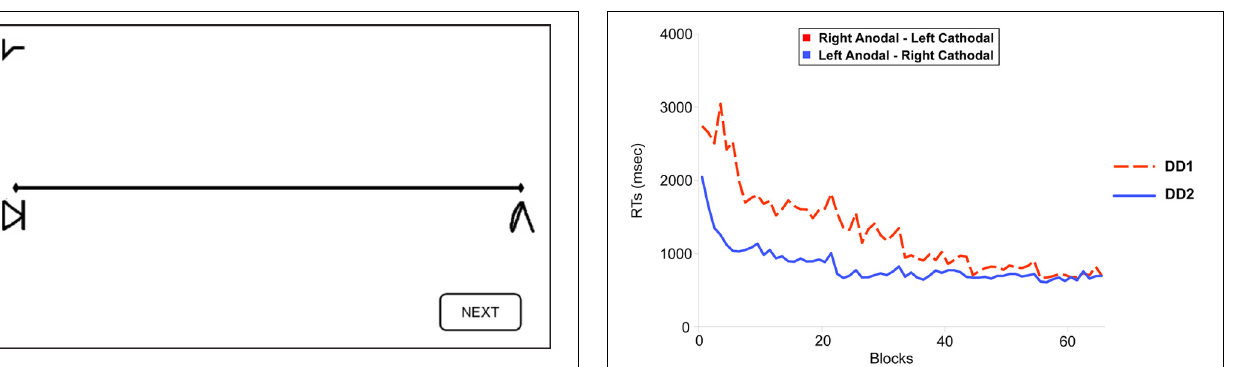
FIGURE 4 | Learning functions for the two DD individuals. DD1 received Right Anodal—Left Cathodal (RA-LC) stimulation to the PPC (dotted red line); DD2 received Left Anodal—Right Cathodal (RC-LA) stimulation to the PPC (solid blue line). The improvement in the learning task over blocks (x-axis) was modeled using a power law function. Non-linear regression showed an equivalent fit for both participants (RA-LC, R = 0 . 9; RC-LA, R = 0 .